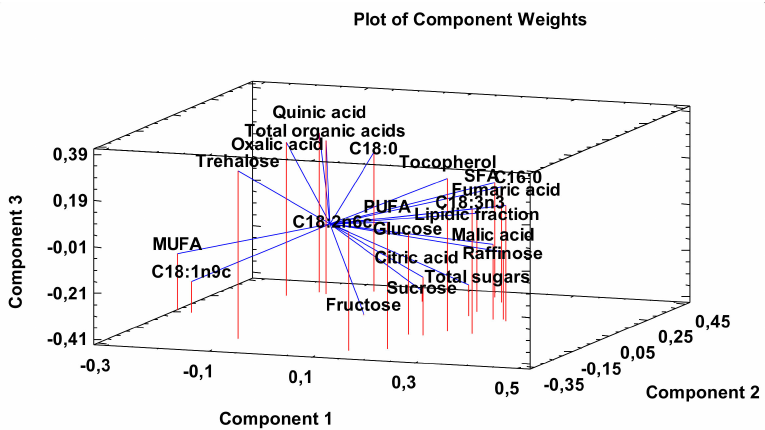
Figure 5. The principal components loading plot of the tested variables at di ff erent maturation stages of cardoonheads. SFA–saturatedfattyacids, MUFA–Monounsaturatedfattyacids, PUFA–polyunsaturated fatty